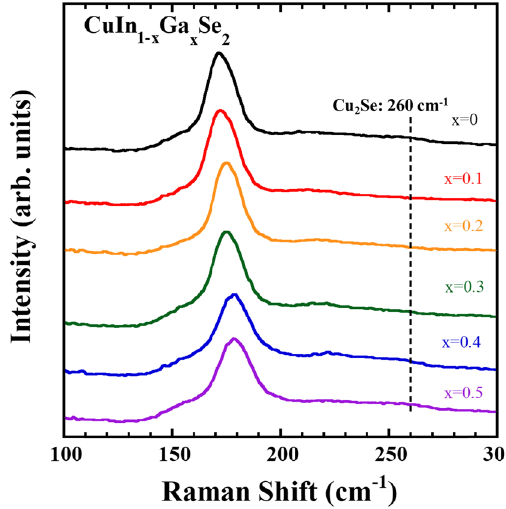
Figure 3: Raman spectra of CIGS single crystals ( Ga content x = 0 – 0.5 ) .